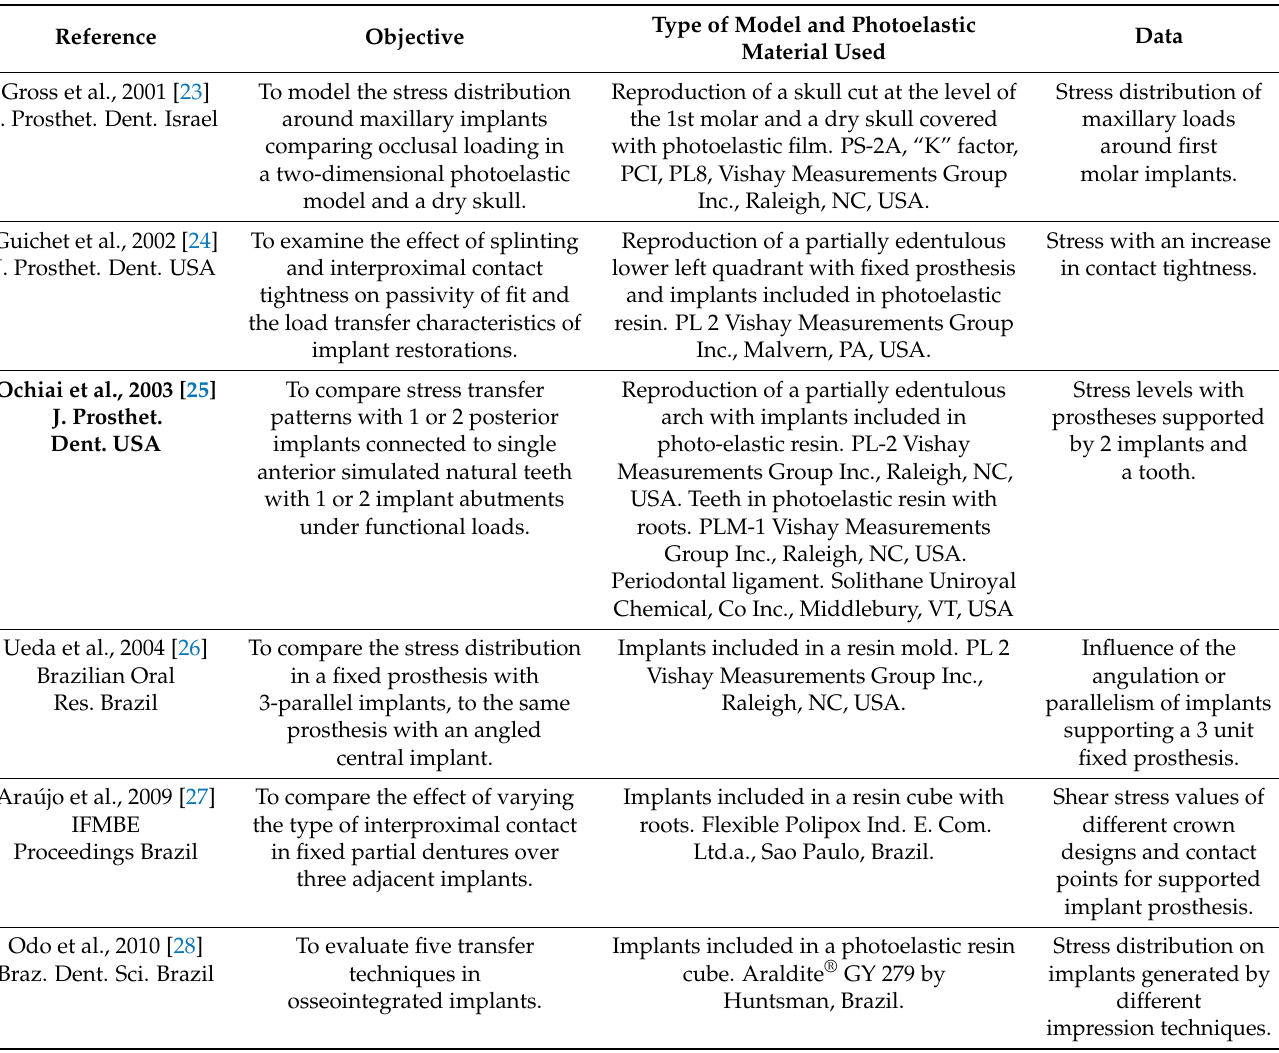
Figure 3. Distribution of articles by area of application. Table 1. Characteristics and findings of studies on implants for fixed prostheses in the dental area.